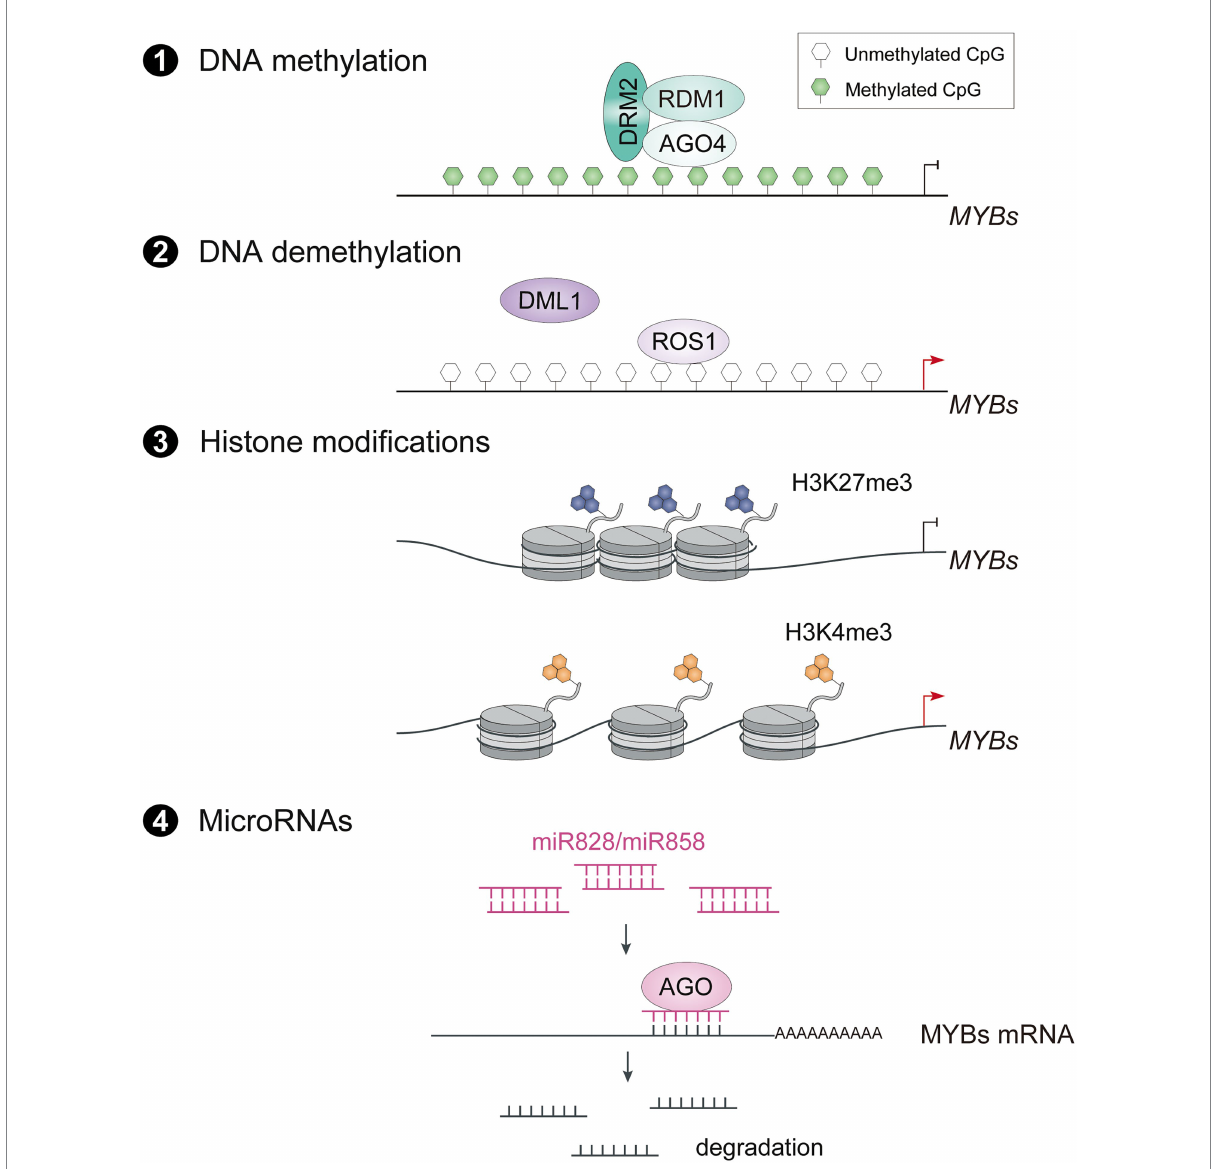
FIGURE 2 Epigenetic and posttranscriptional regulation on expression of R2R3-MYB activators. The transcript level of R2R3-MYB activators is also regulated through AGO4 mediated RNA-directed DNA methylation (RdDM) pathway (1), ROS1 mediated DNA demethylation (2), Histone modifications (3) and miR828/miR858 mediated degradation of mRNAs (4). ROS1, repressor of silencing 1; DML1, demeter-like 1; H3K27me3, trimethylation at lysine 27 of histone H3, H3K4me3, trimethylation at lysine 4 of histone H3; AGO,